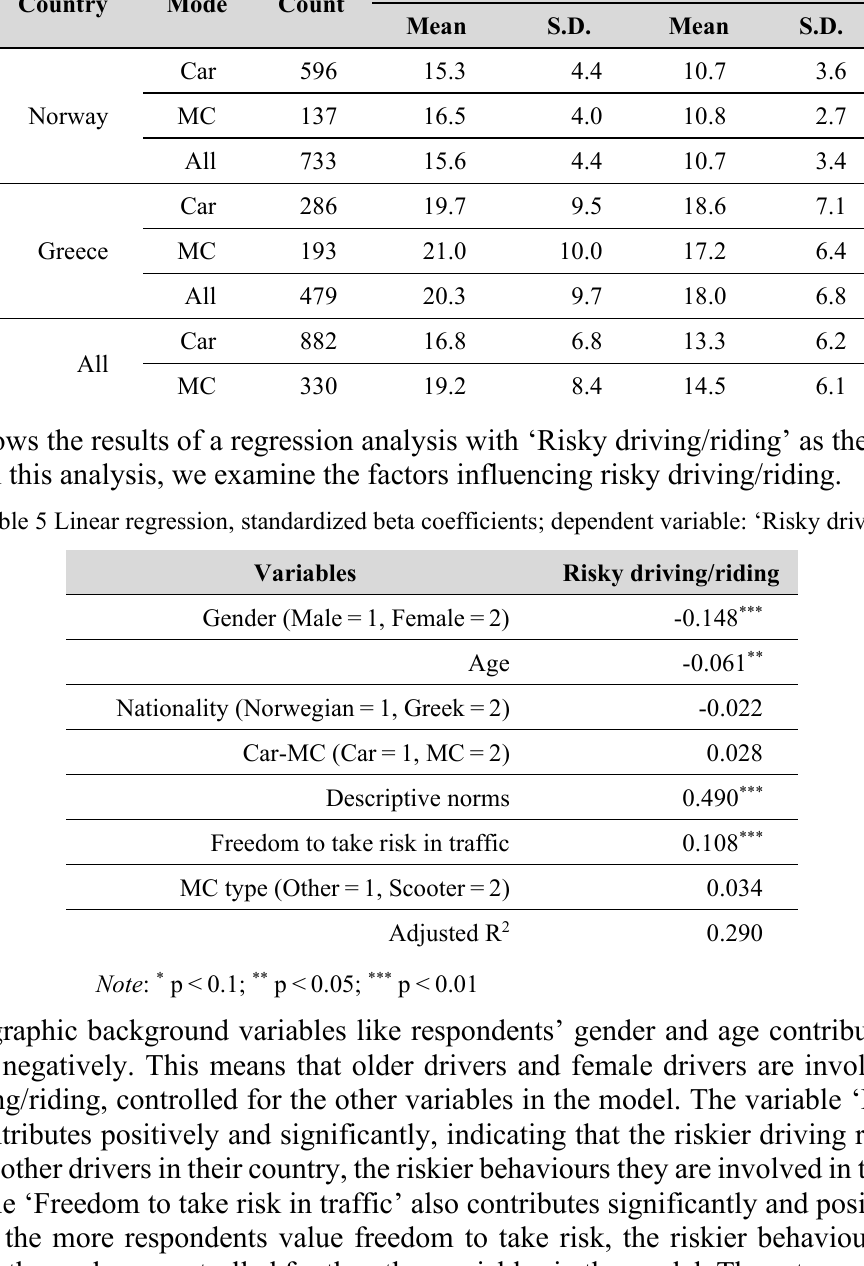
Table 4 Mean scores on the index measuring risky driving/riding and the index measuring descriptive norms, among car drivers and motorcycle riders in the two countries Country